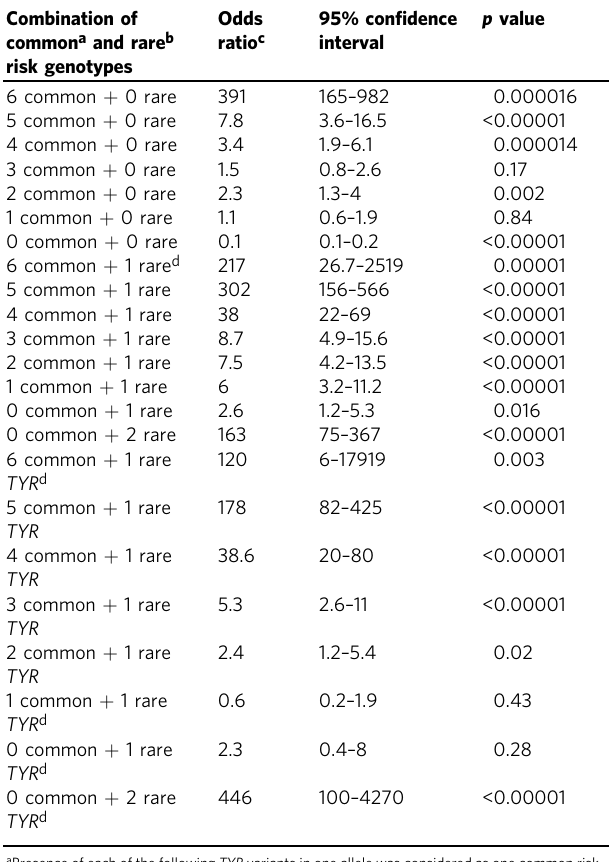
all molecular diagnoses can be found in Supplementary Data 1. Table 5). We expect that future studies analysing visual function and